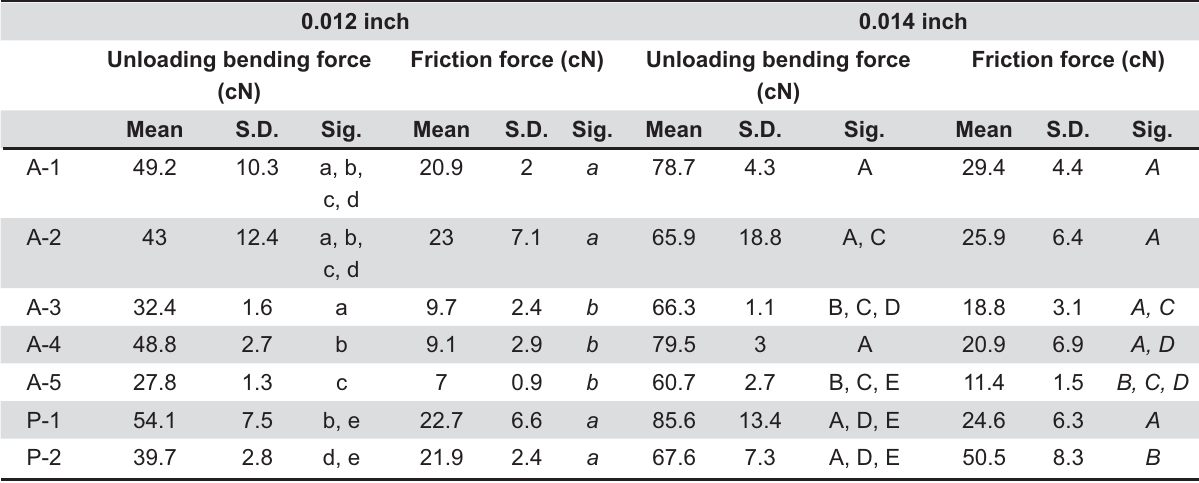
Table 1- Unloading bending and friction forces at a displacement of 0.5 mm